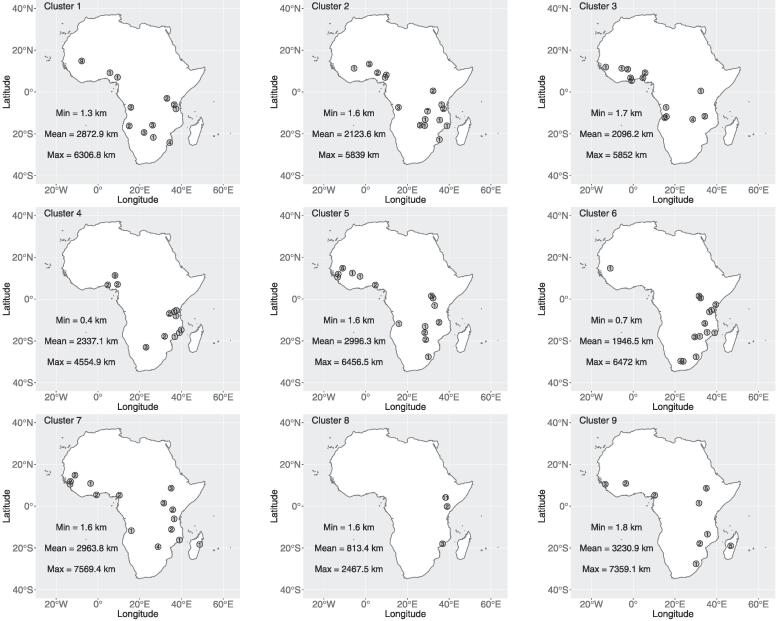
The spatial distribution of soil samples within each cluster. Symbols are labelled according to the number of samples at a given Sentinel site. Min, Mean and Max represent the minimum, mean and maximum distance between soil samples within the cluster, respectively.